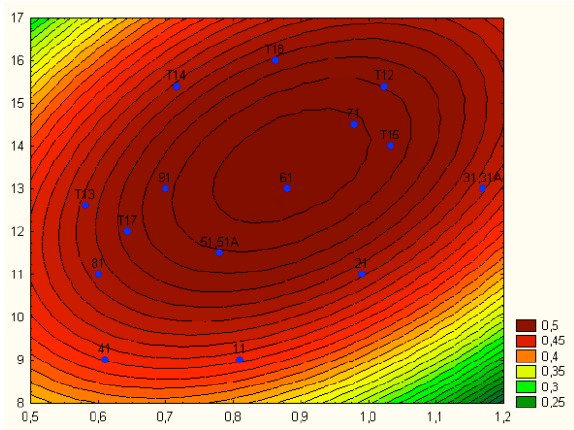
Fig. 26. Manual manner of butt weld deposition with back